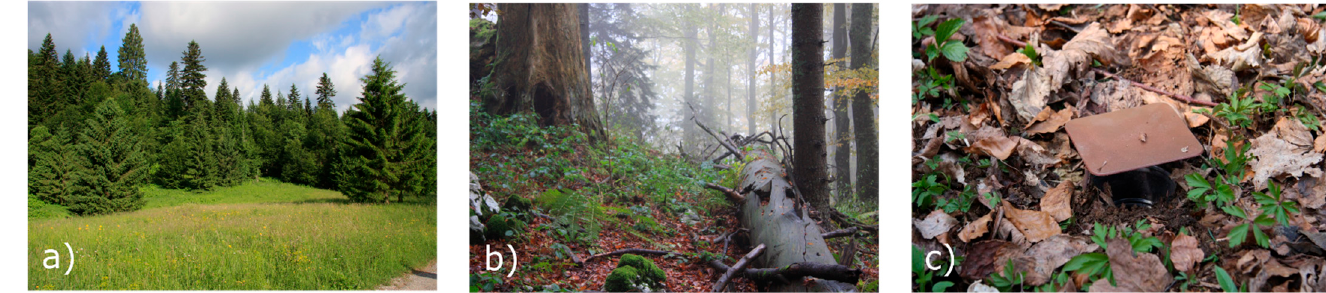
Figure 1. ( a ) managed Dinaric beech–fir forest and adjacent meadow, ( b ) the primeval Č orkova Uvala Dinaric beech–fir forest, ( c ) pitfall trap installed at one of the sampling sites in the Dinaric beech–fir forest, Croatia.